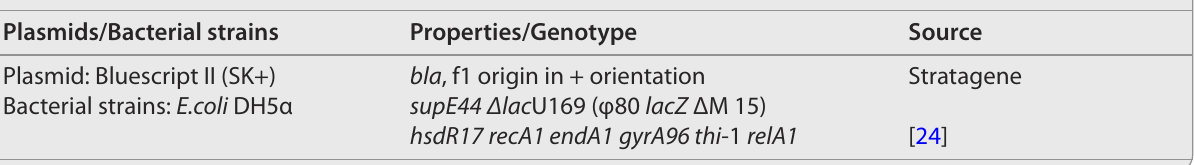
Table 2. Plasmids and bacterial strains used Plasmids/Bacterial